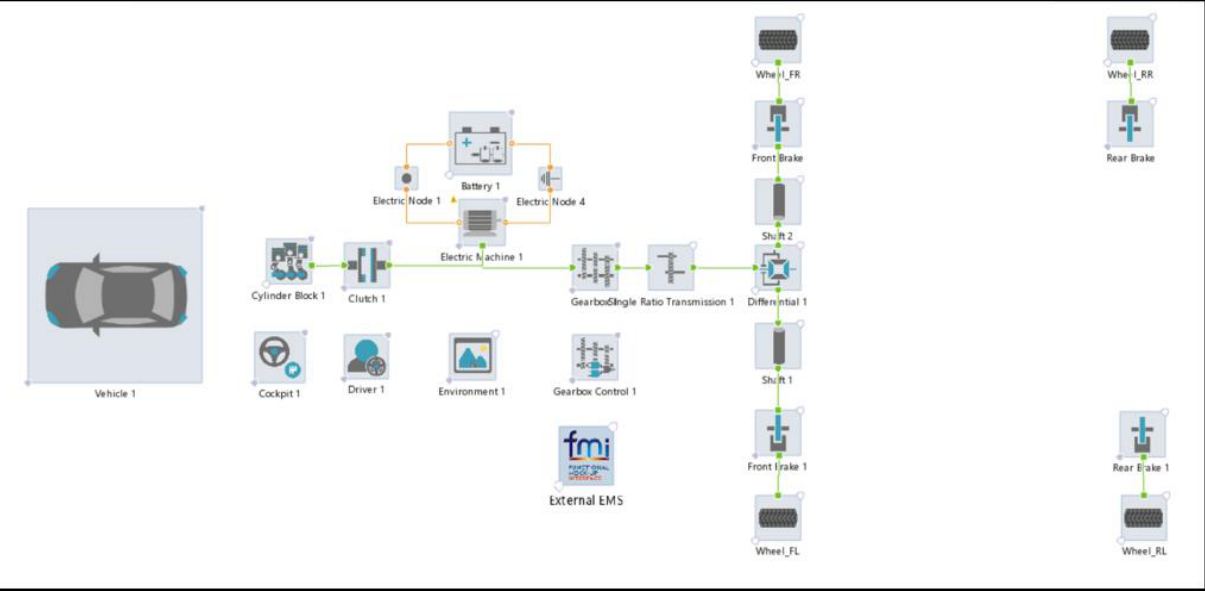
Figure 9. AVL CruiseM TM HEV model with parallel architecture and P2 configuration.